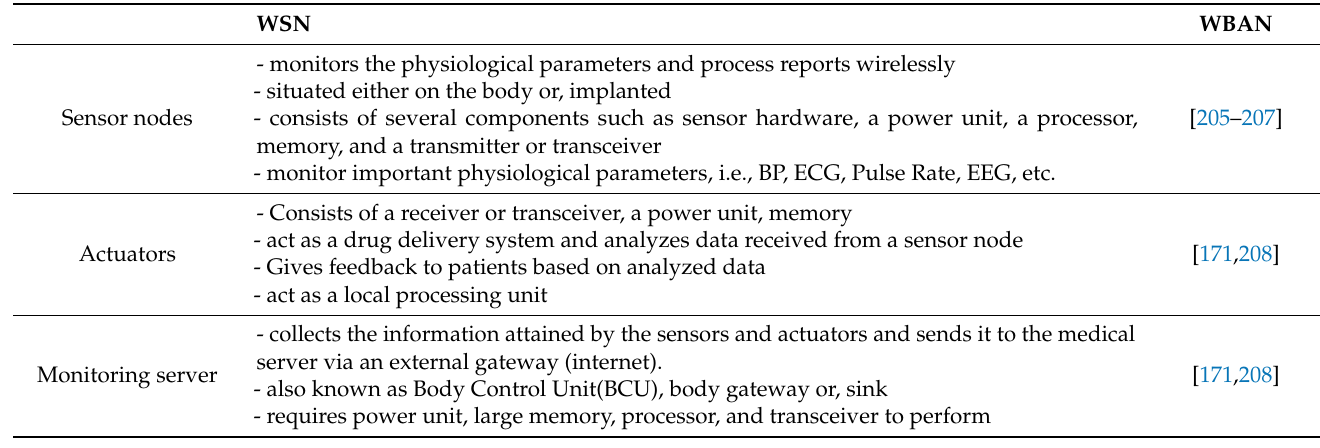
Table 4. Devices used in WBAN.